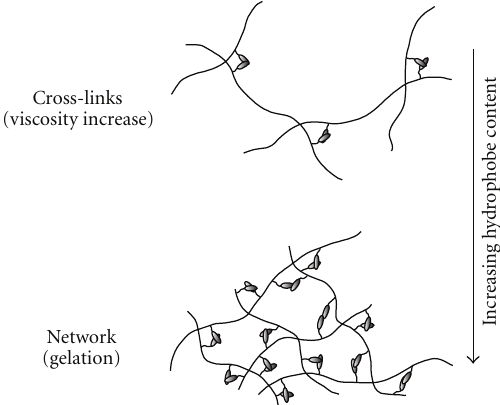
Figure 2: Interpolymer hydrophobe